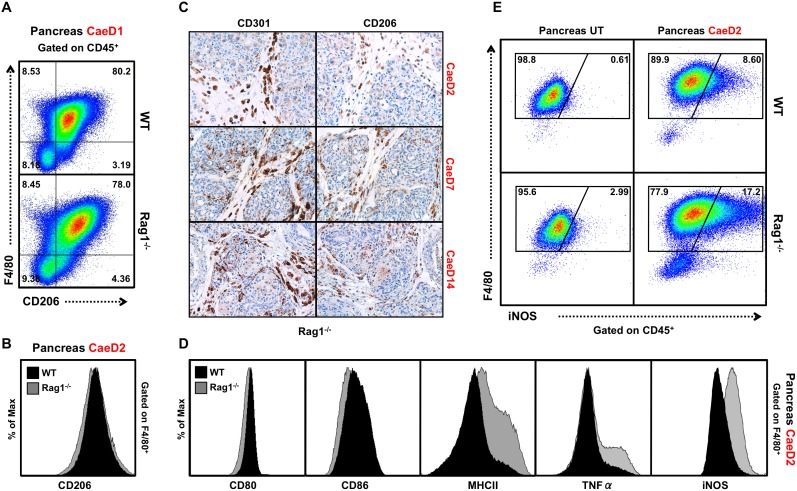
Inflammatory activation of macrophages is increased in Rag1−/− mice before and after injury.(A and B) Representative FACS plots characterizing expression of the CD45+ immune cells that are F4/80+ and CD206+ in the pancreatic immune infiltrate at CaeD1 and CaeD2 (n = 8). (C) Representative immuno-histochemical staining of CD301+ and CD206+ cells in Rag1−/− mice treated with caerulein at designated time points. (D) Representative FACS plots characterizing F4/80+ macrophages isolated from the pancreas of WT and Rag1−/− mice at CaeD2 (n = 4–8). (E) Representative FACS plots of iNOS expression from macrophages isolated from the pancreas of WT and Rag1−/− mice in untreated and CaeD2 treated mice (n = 4–8).